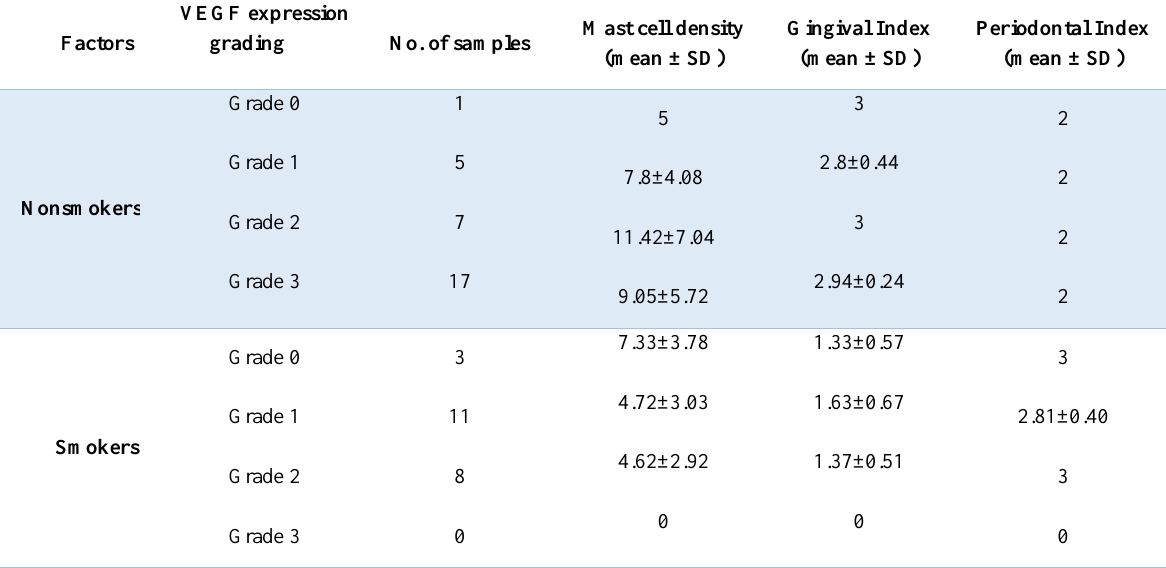
Table1. Mean Mast Cell Density, Gingival Index, Periodontal Index and VEGF Expression Grades in Nonsmokers and